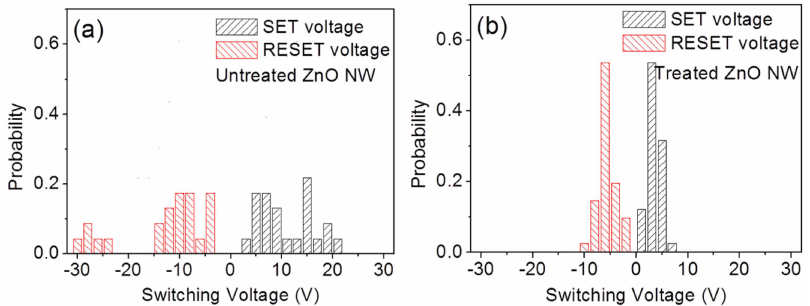
Figure 4. Distributions of switching voltages of the ZnO NW–based memories ( a ) without and ( b ) with argon plasma treatment.